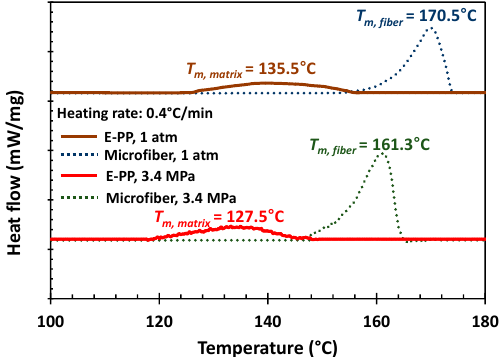
Figure 8. Differential scanning calorimetry (DSC) scans at heating rate of 0.4 °C/min at 1 atm and 3.4 MPa. Table 1. Polymer characteristics.